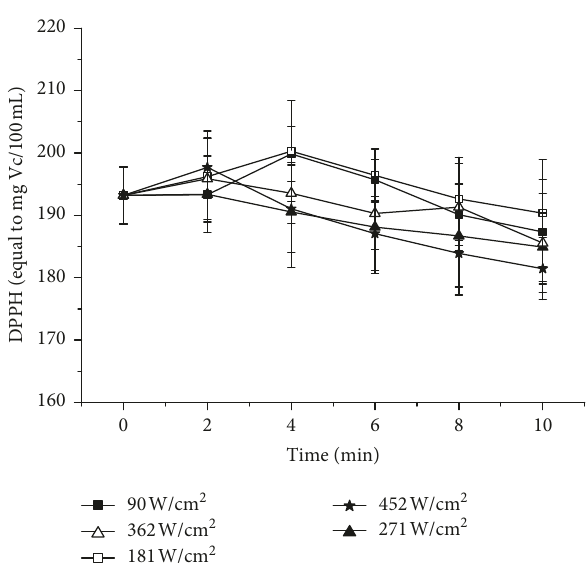
Figure 4: Effects of ultrasound processing on antioxidant activity of bayberry juice.